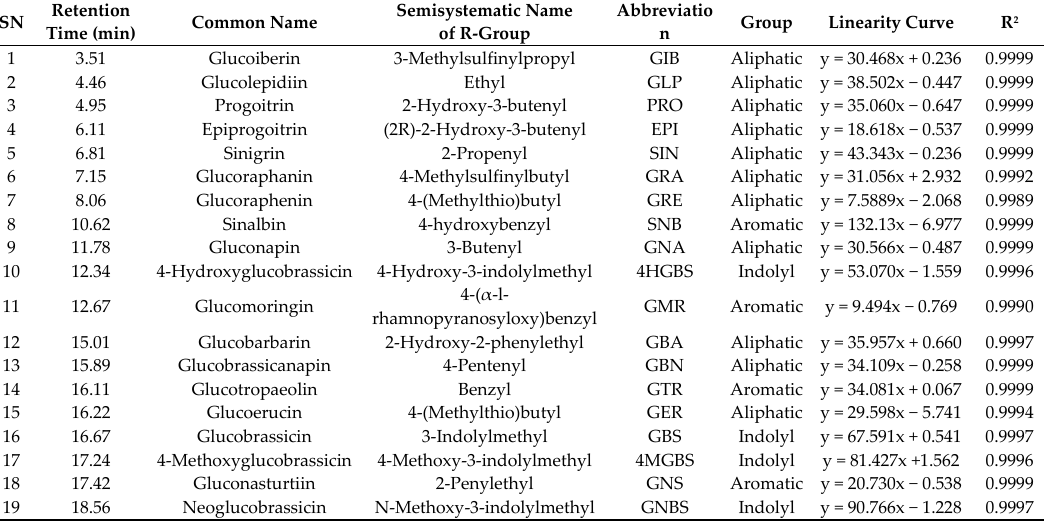
Table 1. High performance liquid chromatography (HPLC) determination of 19 desulfo- glucosinolates studied in cabbage genotypes.